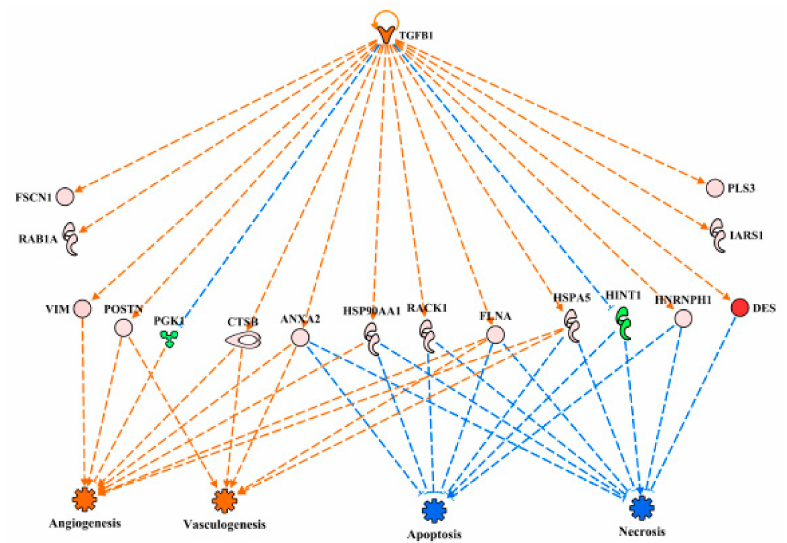
Figure 7. The regulatory network of TGFB1 in wooden breast (WB) myopathy leading to predicted activations of angiogenesis and vasculogenesis and inhibition of apoptosis and necrosis through downstream target proteins in WB myopathy. Protein abbreviations are defined and differential expression of proteins are provided in Supplementary Table